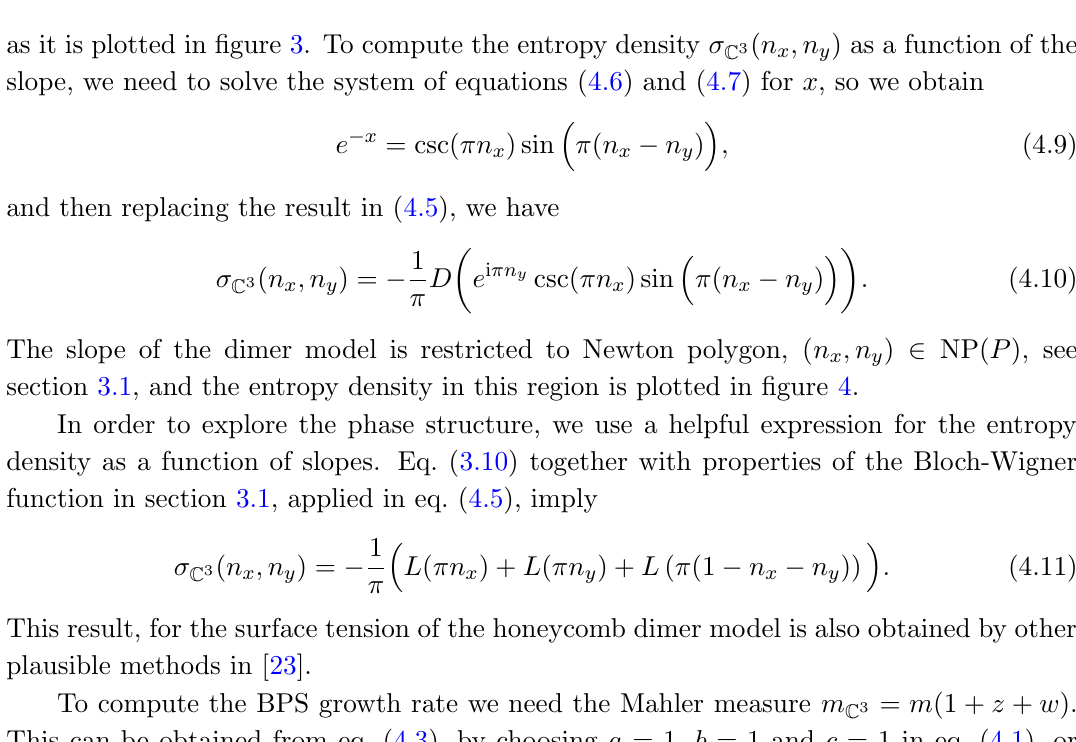
Figure 4 . Minus entropy density of clover